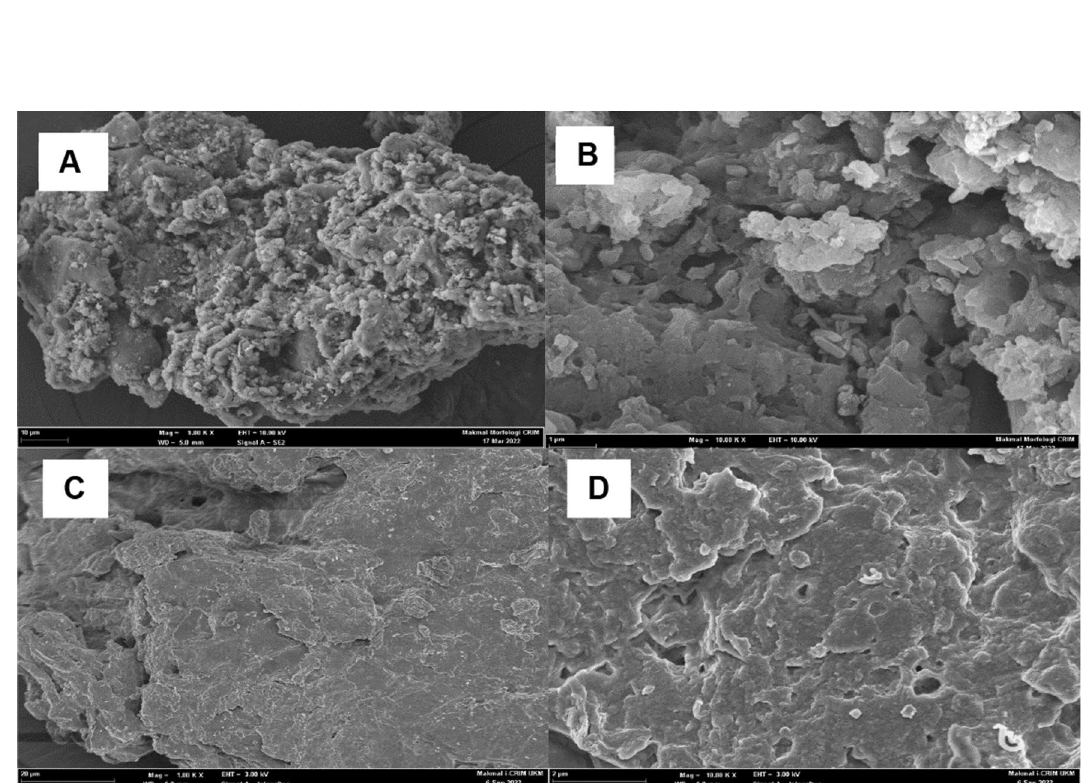
Figure 3. FESEM image of ( A ) cross-sectional of untreated PKC at × 1.00 k magnification ( B ) cross-sectional of untreated PKC at × 10.00 k magnification ( C ) cross-sectional view of pretreated PKC with 3% (w/v) Oxalic acid at 121 °C for 4 hs at × 1.00 k magnification ( D ) pretreated PKC at × 10.00 k